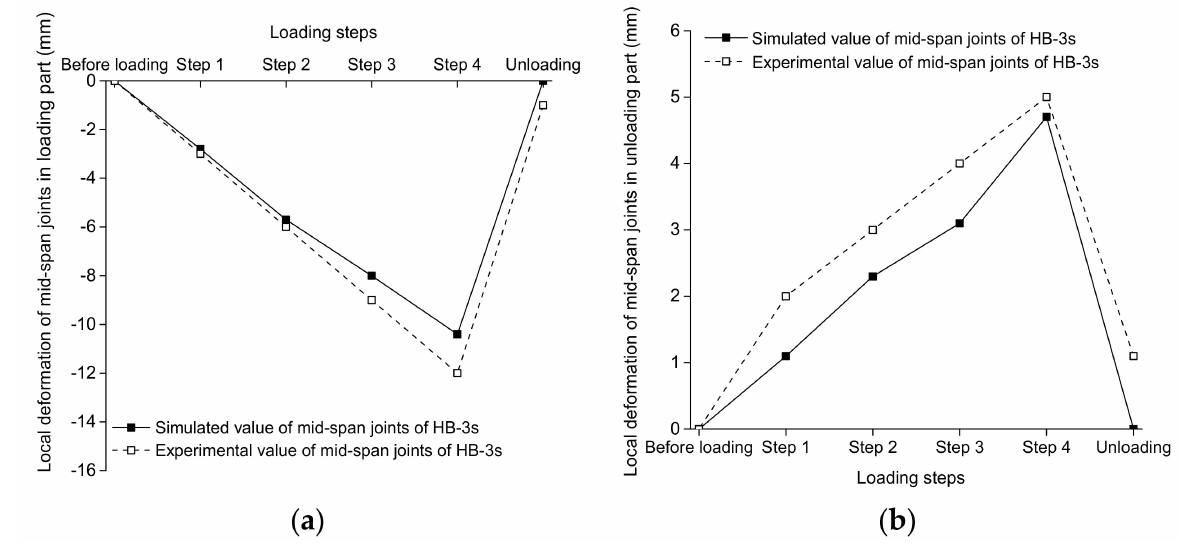
Figure 27. Mid-span joints on the HBs for the half-span static loading test. ( a ) Loading part; ( b ) Unloading part. Table 7. Variations in the average cable forces of the half-span static loading test (unit: kN). Measuring Point